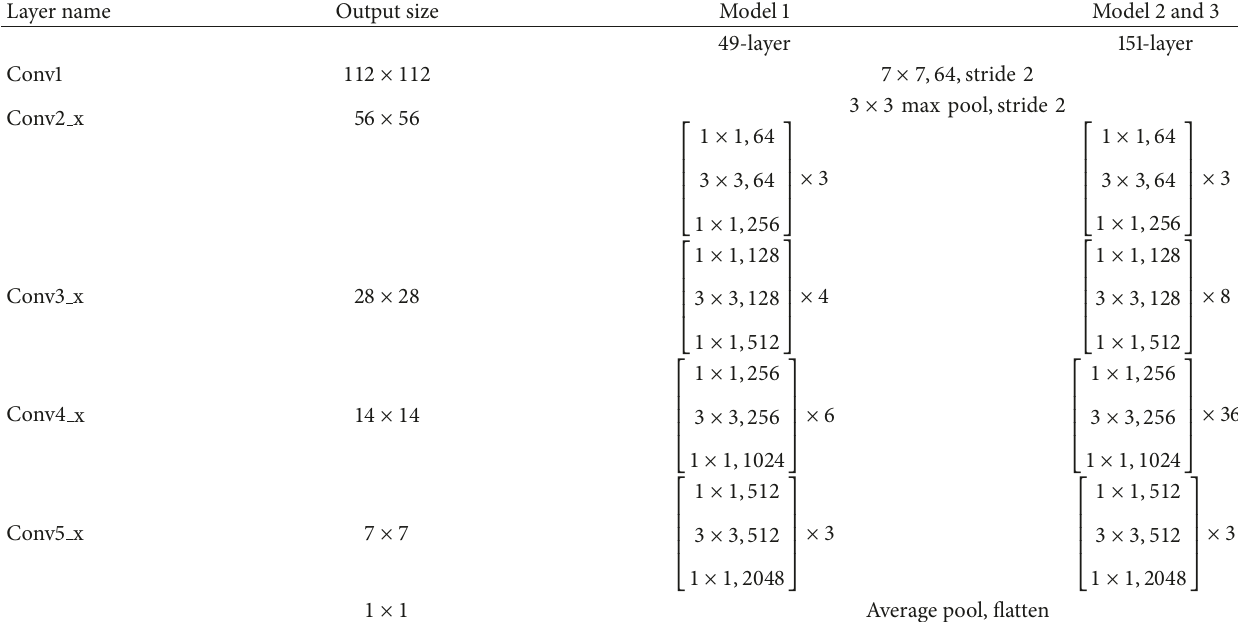
Table 2: Architectures of feature extraction